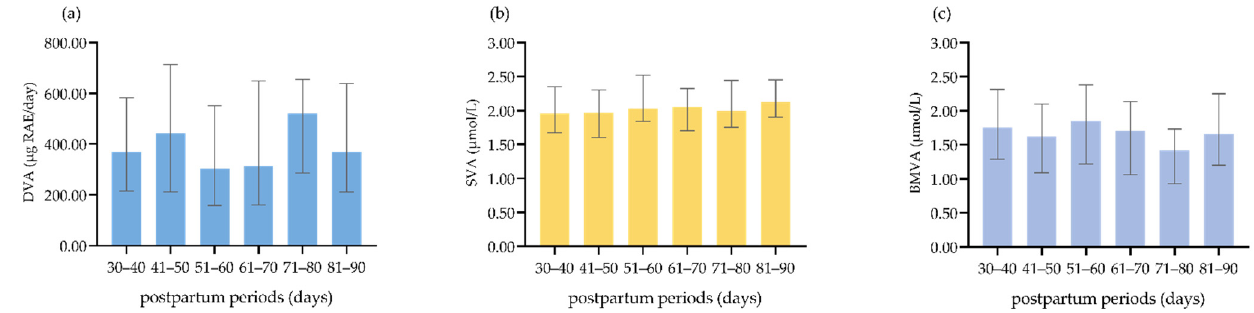
Figure 1. ( a ) DVA at different postpartum periods; ( b ) SVA at different postpartum periods; ( c ) BMVA at different postpartum periods.